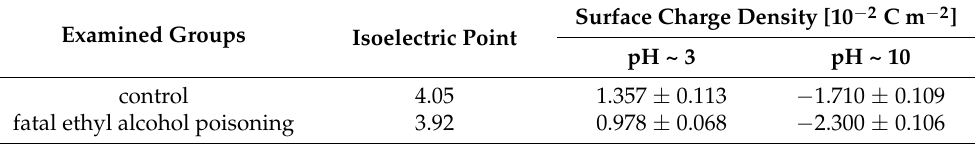
Table 1. The isoelectric point and surface charge density values for red blood cells (RBCs) (control and fatal ethyl alcohol poisoning).